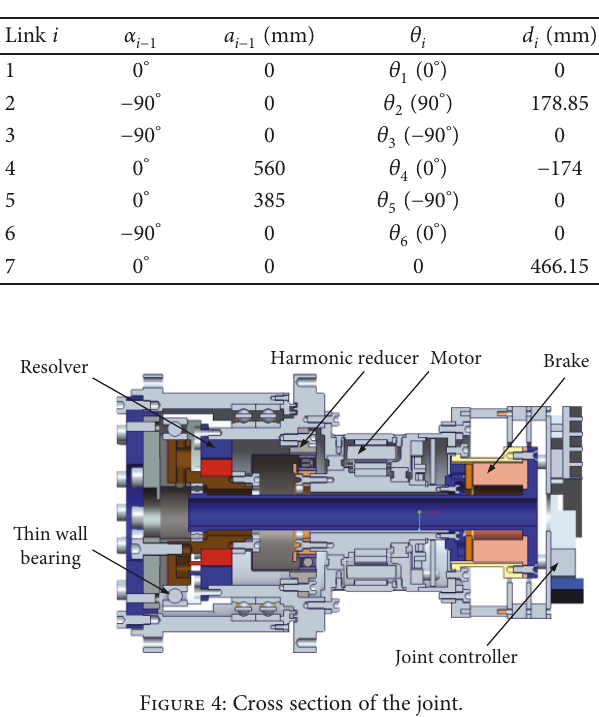
Figure 3: Con fi guration of the manipulator. Table 2: DH parameters of the manipulator.